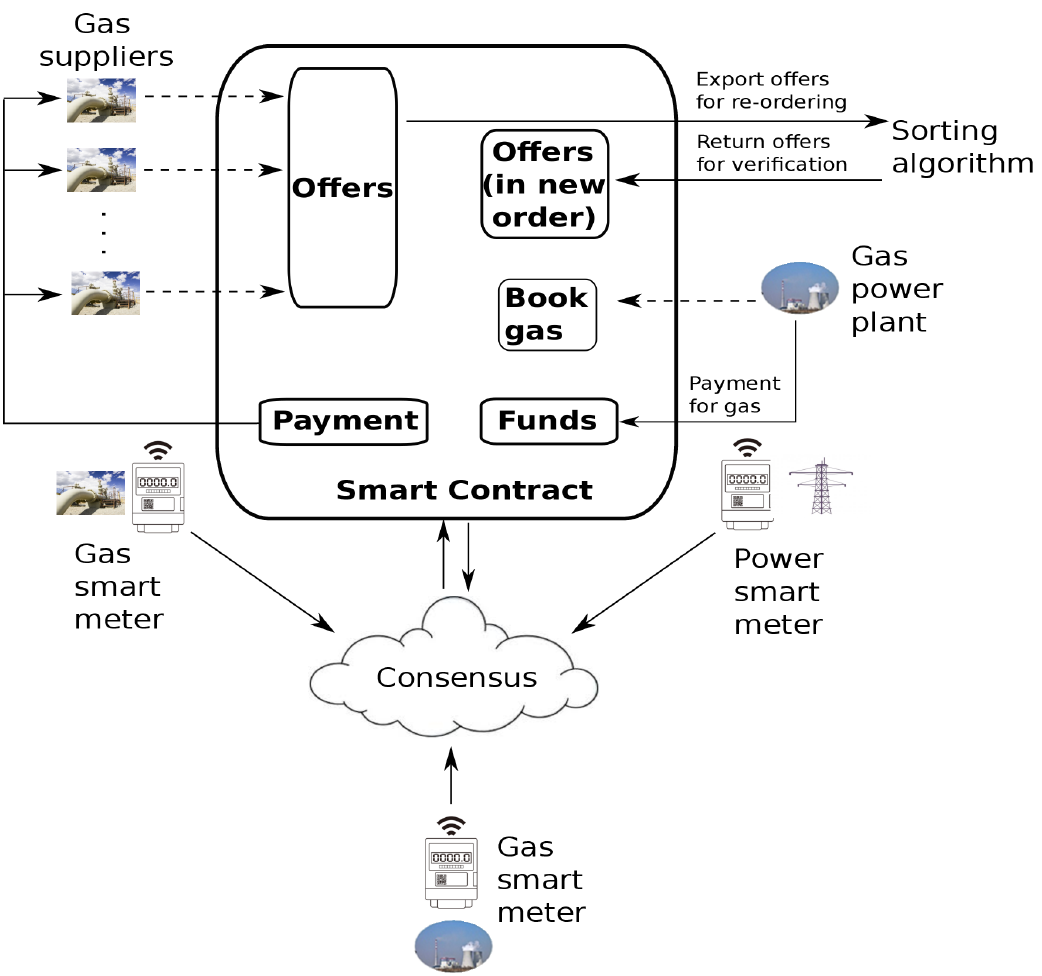
Figure 1. Blockchain-based P2P gas trading scheme with decentralized oracles.